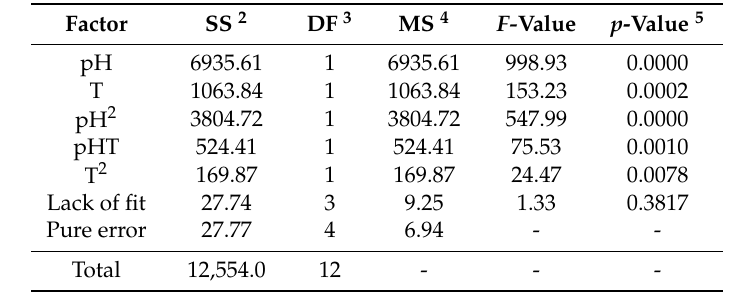
Table 3. ANOVA for the response surface quadratic model for the stability of mLip3 after pH and T treatment for 30 min 1 .